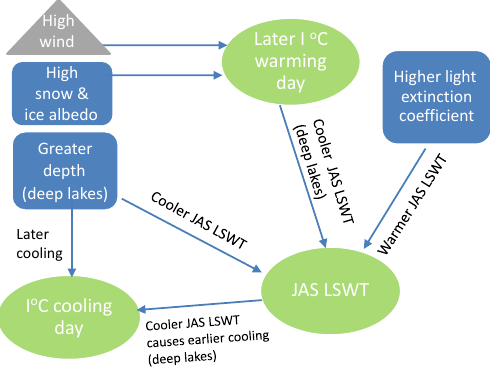
Figure 15 Schematic linking the modelled interactions between the lake surface water Figure 15. Schematic linking the modelled interactions between the temperature (LSWT) regulating parameters: lake depth ( d ), snow and ice albedo ( α ) and light extinction coefficient ( κ ), shown in squares and wind (shown in triangle) with the LSWT lake surface water temperature (LSWT)-regulating parameters: lake depth ( d) , snow and ice albedo ( α) and light extinction coefficient ( κ) , shown in squares and wind (shown in triangle) with the LSWT metrics: 1 ◦ C cooling day, 1 ◦ C warming days and July–August– September (JAS) LSWTs (shown in